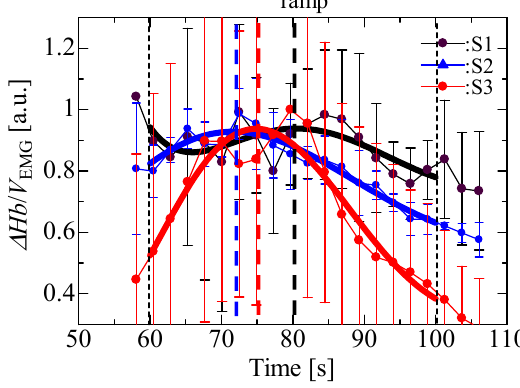
Figure 7. Δ Hb/EMG in isometric ramp contraction.